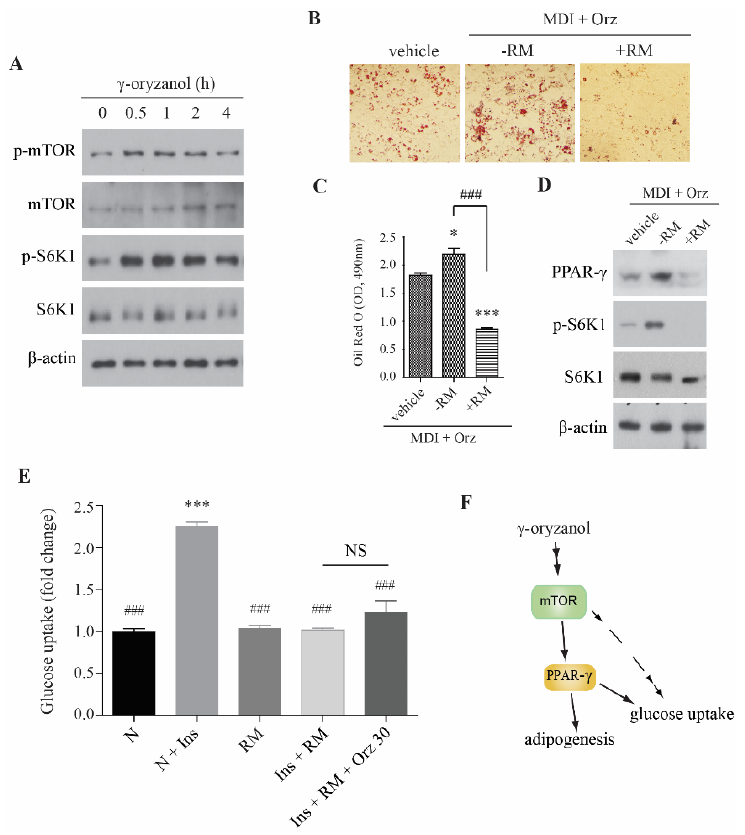
Figure 3. Effects of γ-oryzanol (Orz) on mammalian target of rapamycin (mTOR) signaling in 3T3-L1 adipocyte cells. ( A ) Orz enhances mTOR signaling in 3T3-L1 preadipocytes. Cells were treated with 30 μM Orz for indicated times. ( B ) Orz promotes cell differentiation in mTOR-dependent fashion. 3T3-L1 cells were treated with Orz during adipocyte differentiation for 8 days. Rapamycin (RM) was added from day 0 to 2. Lipid accumulation was visualized by Oil Red O staining. ( C ) Quantification of the relative intensity of the Oil Red O, at a wavelength of 490 nm. Values are means ± SEM, n = 3, * p < 0.05; *** p < 0.001 compared to vehicle. ### p < 0.001 compared to rapamycin treated cells. ( D ) Protein expression was analyzed using immunoblot with phospho-S6K1, S6K1, PPAR-γ, and β-actin antibodies. S6K1, 70-kDa ribosomal S6 kinase; PPAR-γ, peroxisome proliferator-activated receptor gamma. ( E ) Rapamycin (RM) co-treatment reduces glucose uptake. 3T3-L1 cells were treated Orz for 18 h. Cells were incubated with 100 nM insulin (Ins) and 50 μM 2-NBDG for 15 min, followed by incubation with or without RM for 1 h and then fluorescence intensity of cellular 2-NBDG was measured. ( F ) Proposed mechanism for the effect of Orz on adipogenesis and glucose uptake. Values are means ± SEM, n = 3, *** p < 0.001 compared to vehicle. ### p < 0.001 compared to N + Ins